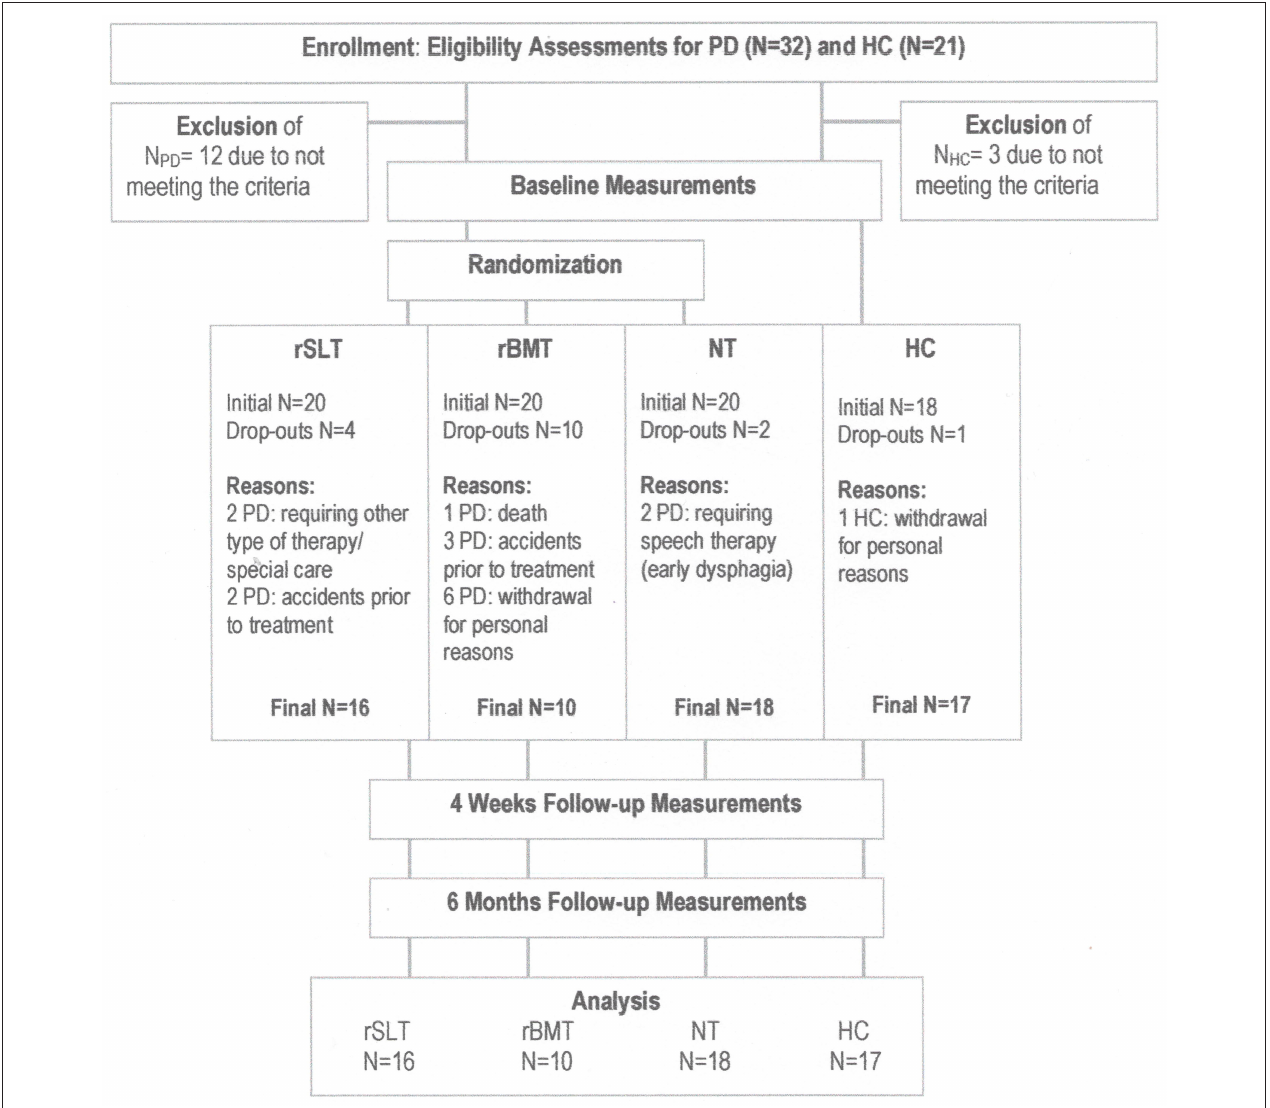
FIGURE 1 | Flow chart outlining participant enrollment, treatment and assessments. Importantly, for a simplified visual overview here, all three study tranches of this crossover study have been summarized into one per study arm. The exact study outline of participant numbers per study tranche is presented in Figure 2 .